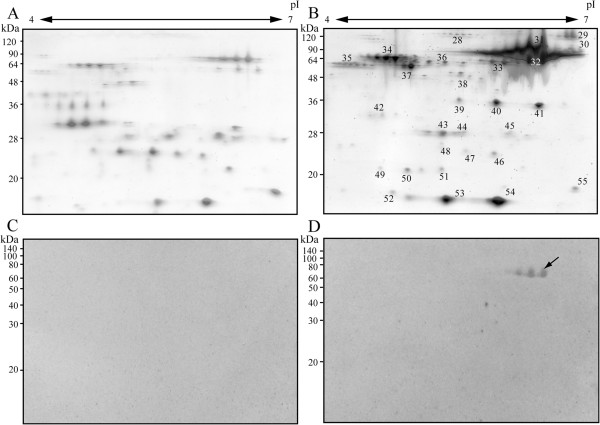
2-DE analysis of normal and infected hamsters urine. Urinary protein patterns of hamsters were compared by 2-DE analysis; (A, C) before infection; (B, D) 7–8 days post-infection. The urine of three hamsters was mixed for each infection period. The total protein content of each sample was 20 μg. Each pattern of urinary protein was separated by pI (4–7), 12.5% acrylamide gel, and subsequently silver staining (A, B), or immunoblotting with anti-L. interrogans pAb was done (C, D). Arrows (D) show spots of 60 kDa that reacted with the polyclonal antibody at 7–8 days post-infection. Each experiment was repeated three times, and the representative data are shown in this figure.